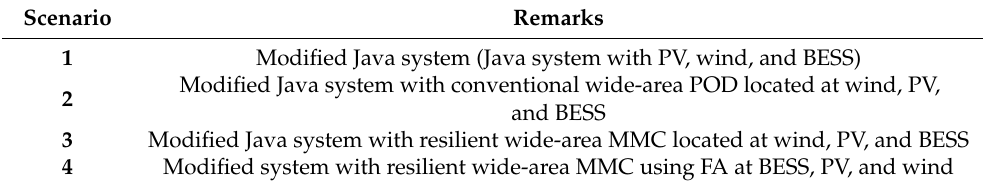
Table 2. Scenarios for simulation